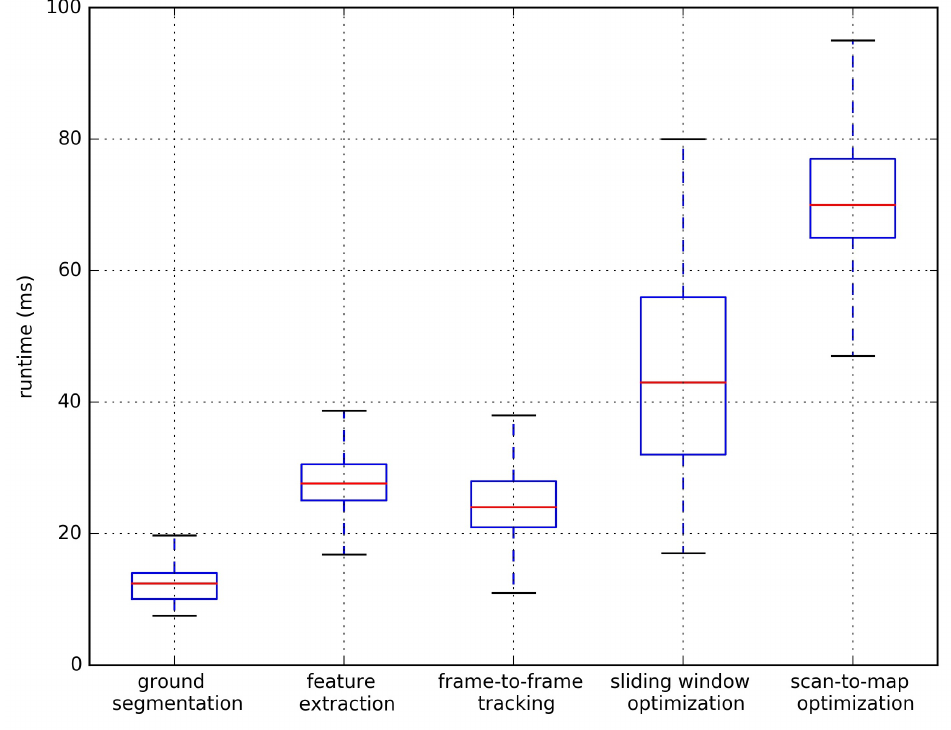
Figure 25. Processing time of each module on the KITTI sequence 00 odometry benchmark.